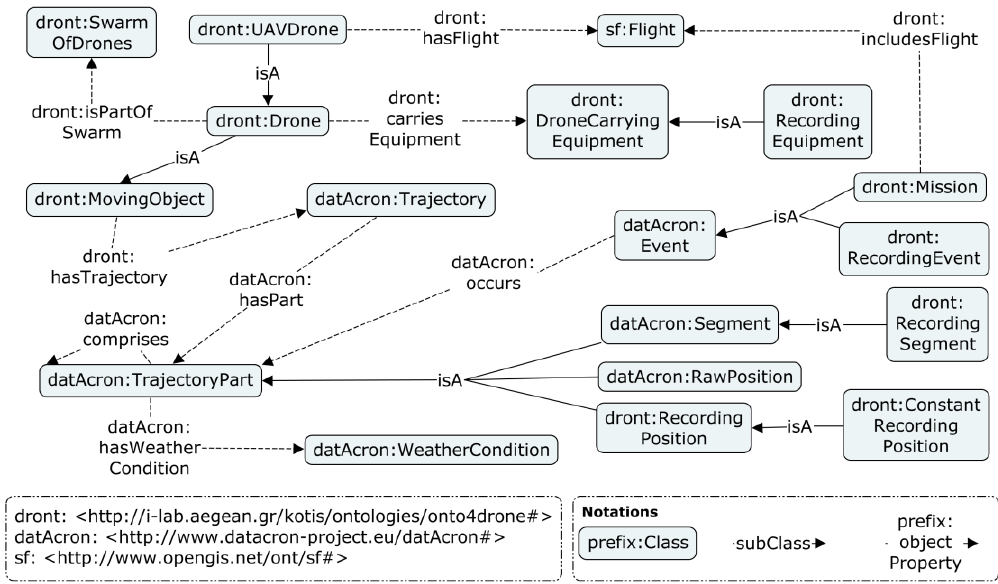
Figure 7. Basic concepts and relations of the Onto4drone ontology.